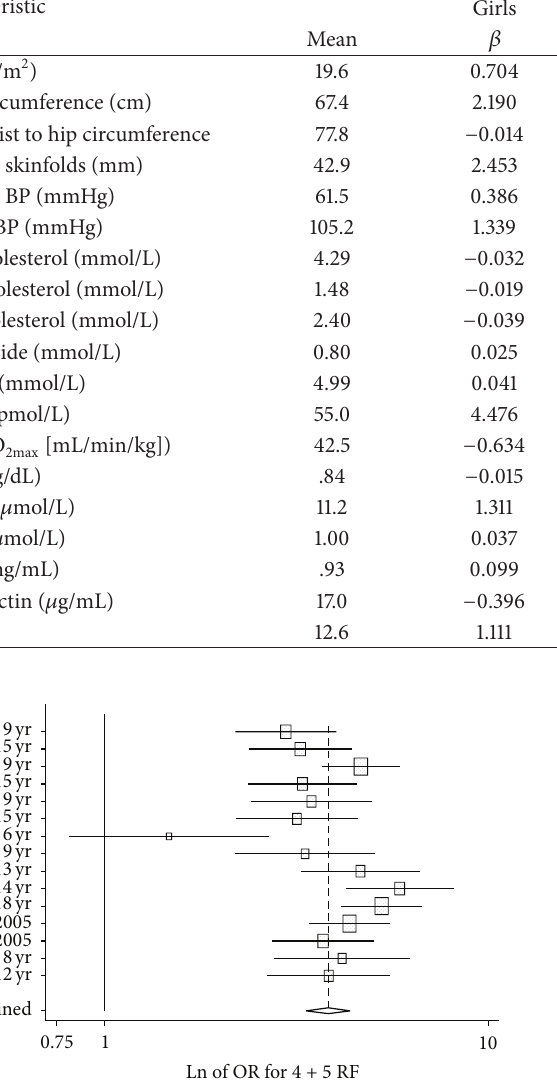
Table 2: Overall mean value and regression 𝛽 -values with risk factors and age. 𝛽 -values were used to calculate age adjusted risk factor levels. Characteristic